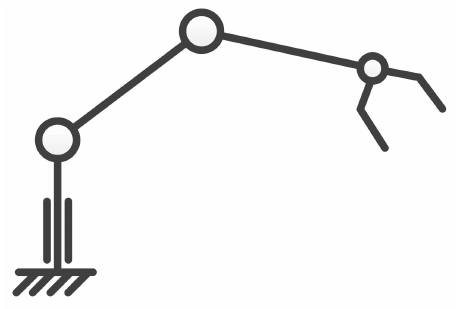
Figure 1. Structural forms of some manipulators with